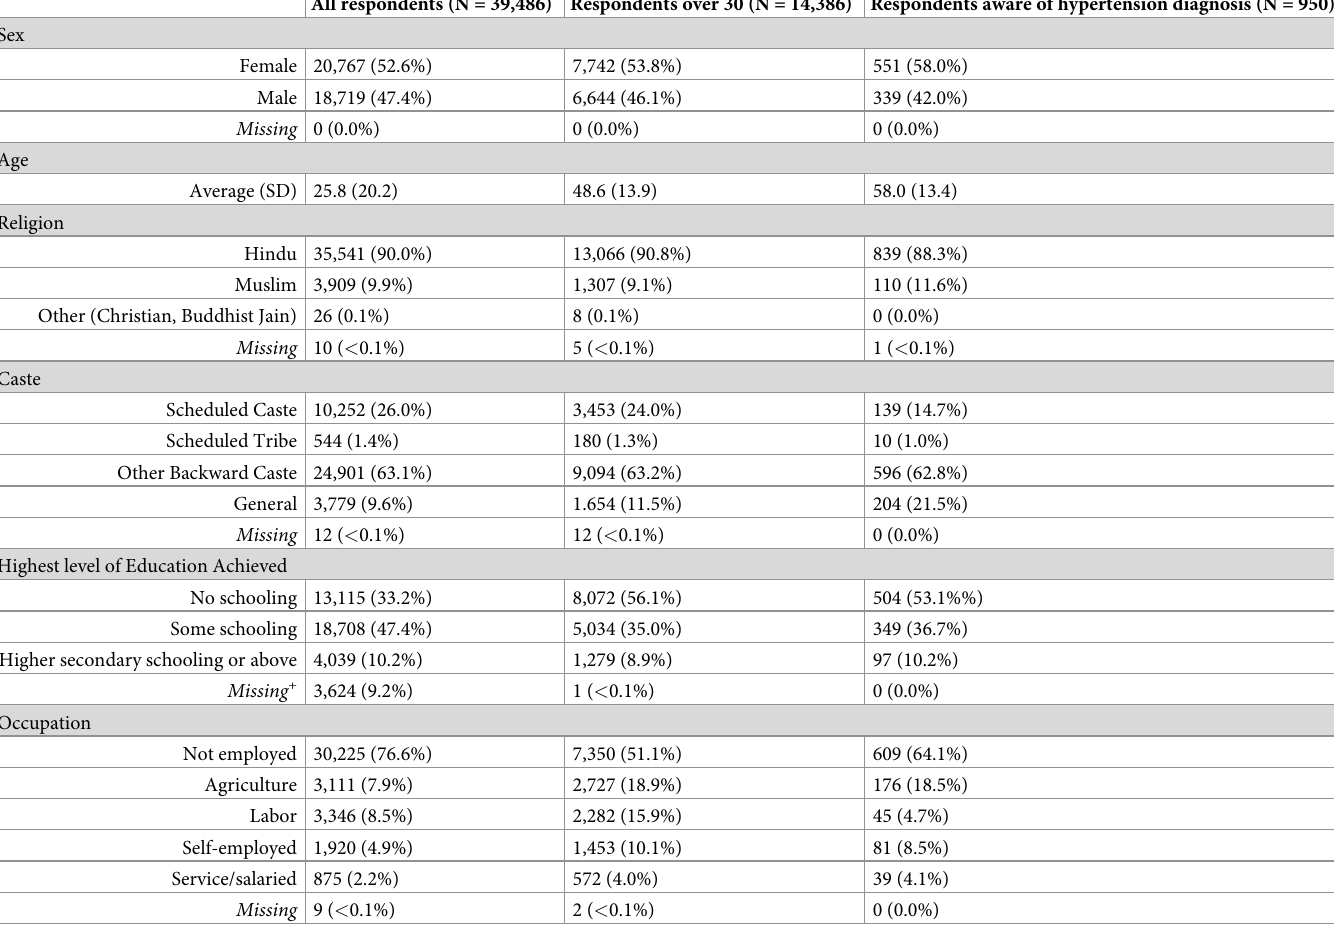
Table 1. Characteristics of household survey